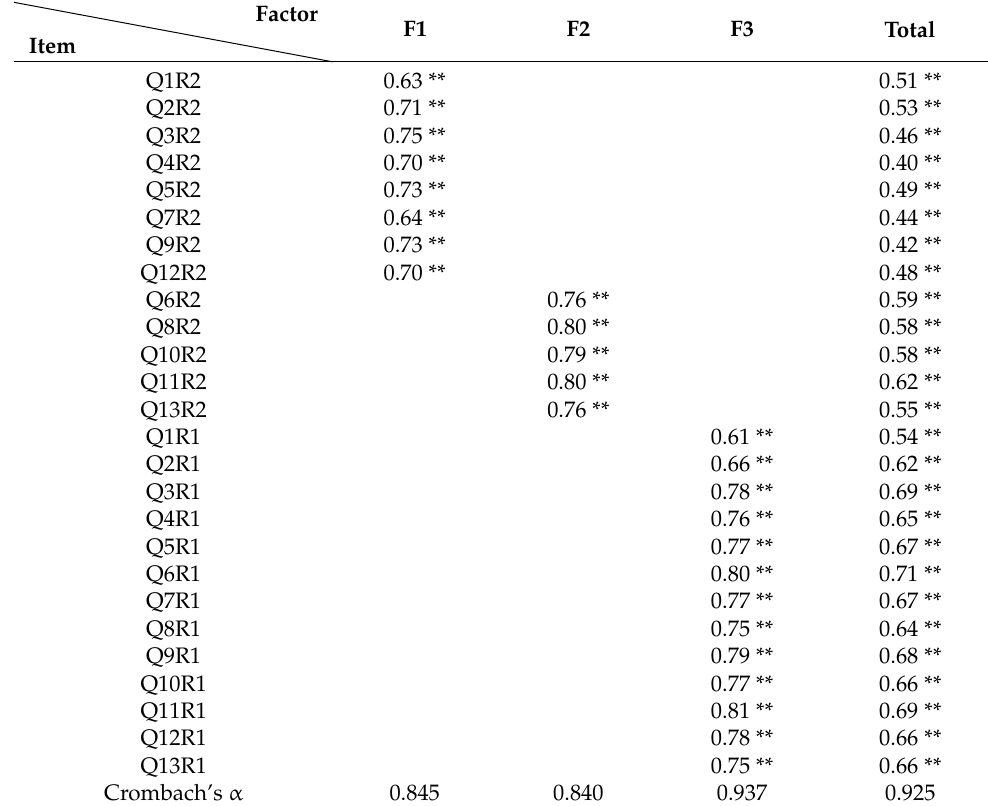
Table 2. Correlations of items and total score.